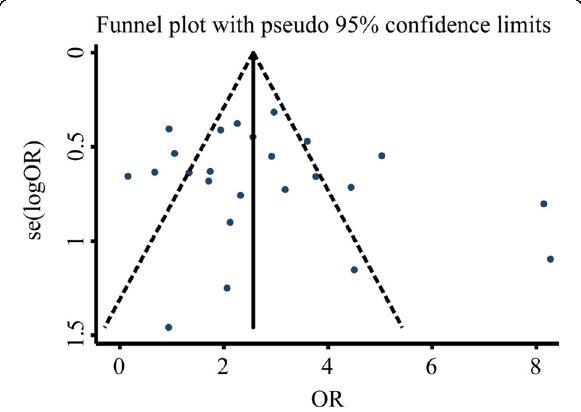
Fig. 6 Inverted funnel plots of bias analysis on total effective rates Fig. 7 Inverted funnel plots of bias analysis on Hp eradication